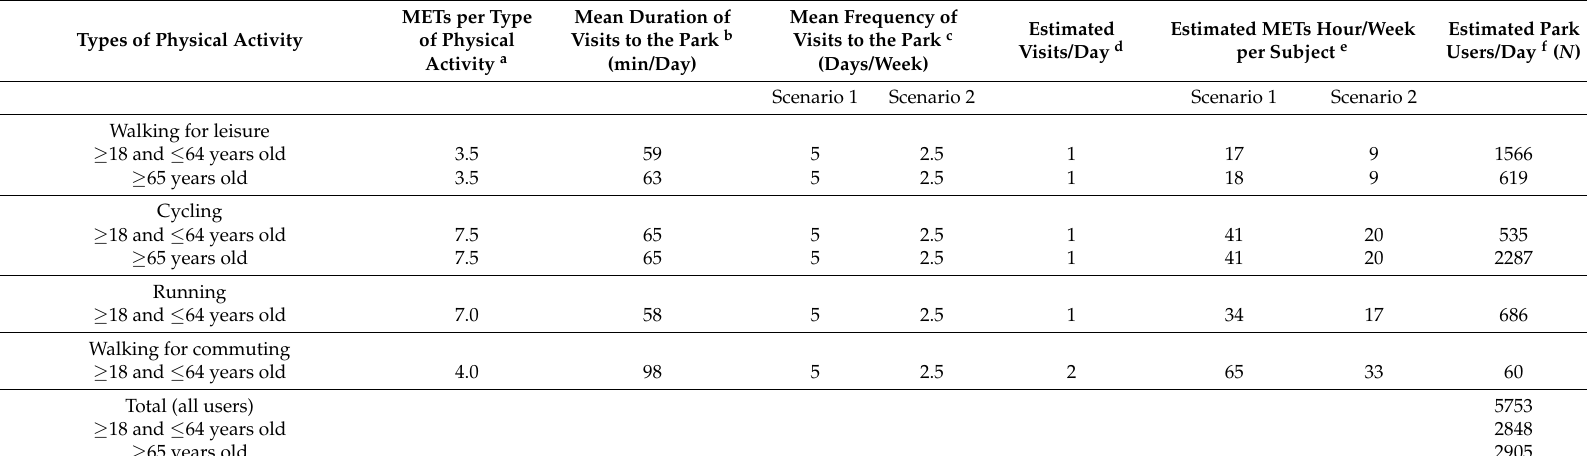
Table 1. Input data (for Scenario 1 and Scenario 2) on adult users of the park and key assumptions used in the